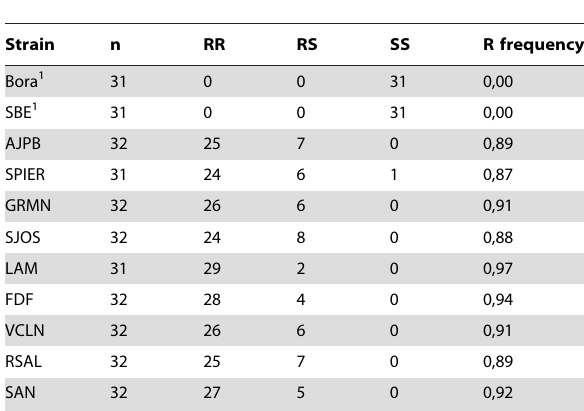
Table 3. Frequency of the V1016I kdr mutation in the populations of Martinique and the two reference strains.